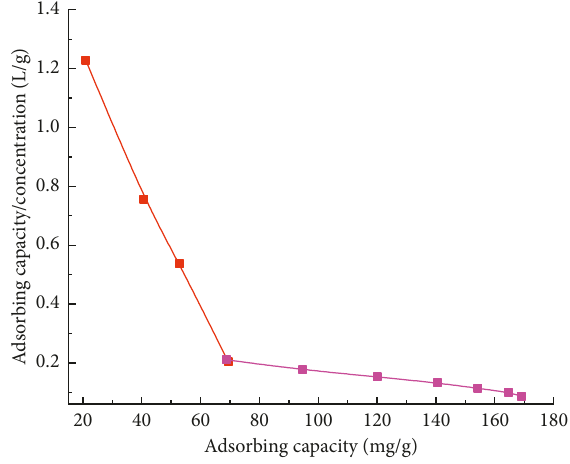
Figure 7: Scatchard’s plot for imazethapyr MIPs.